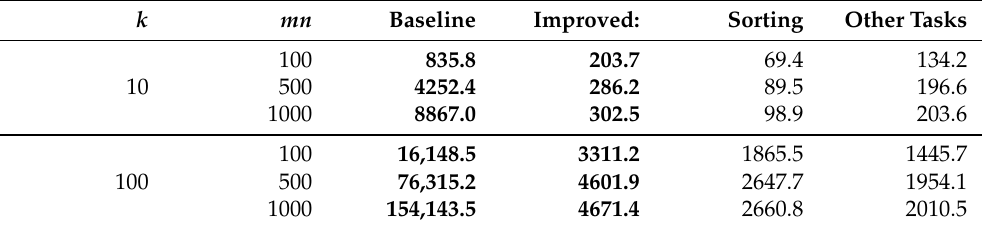
Table 7. Running time (s) of baseline and improved algorithms. Here, ‘baseline’ is same as Task 2 in Table 6 (i.e., the bottleneck); ‘improved:’ is the running time of corresponding task in the improved algorithm, where ‘sorting’ and ‘other tasks’ are the